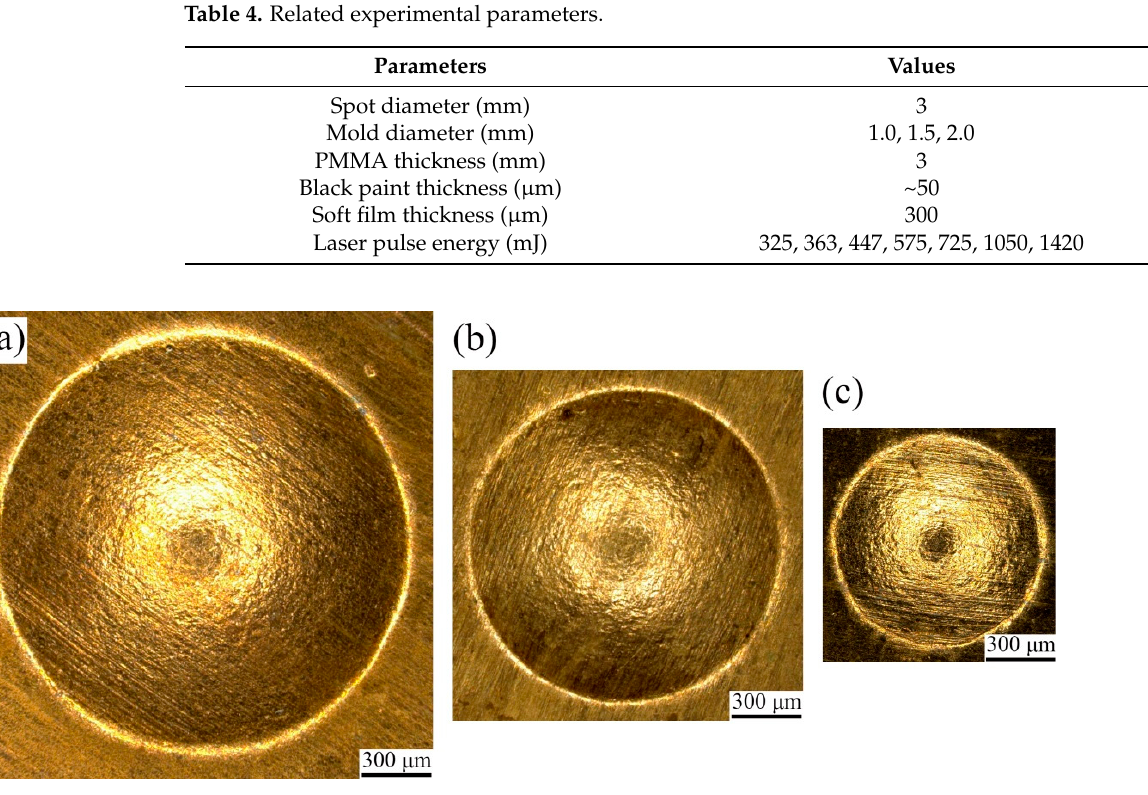
Figure 4. Topography of fine ‐ grained bulging samples under laser pulse energy of 363 mJ. ( a ) λ = 1; ( b ) λ = 0.5; ( c ) λ = 0.25.